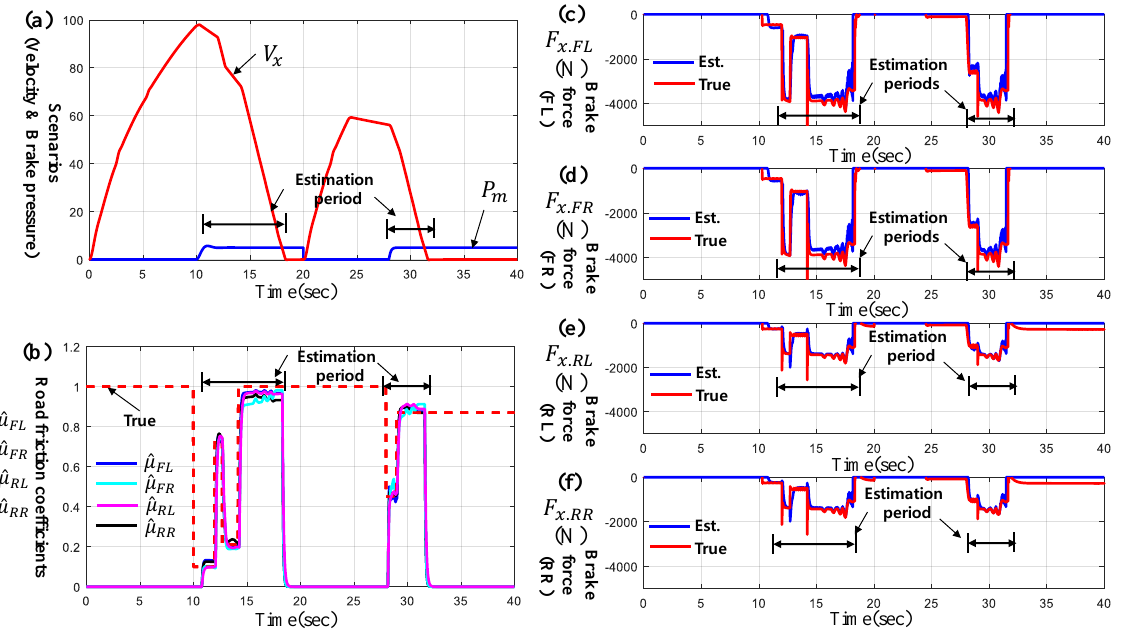
Figure 13. Estimation results of road friction coefficients and brake forces with m v = 1800 kg. ( a ) Vehicle speed and brake scenarios, ( b ) estimates of road friction coefficients, ( c ) brake force of FL wheel, ( d ) brake force of FR wheel, ( e ) brake force of RL wheel, and ( f ) brake force of RR wheel. Figure 13b indicates that the vehicle experiences four-times abrupt changes in friction level during the first brake and twice at the second brake. It can be seen that the estimated friction excellently tracks the abrupt changes of the true friction. Although there are small errors at 15 s, the overall results are